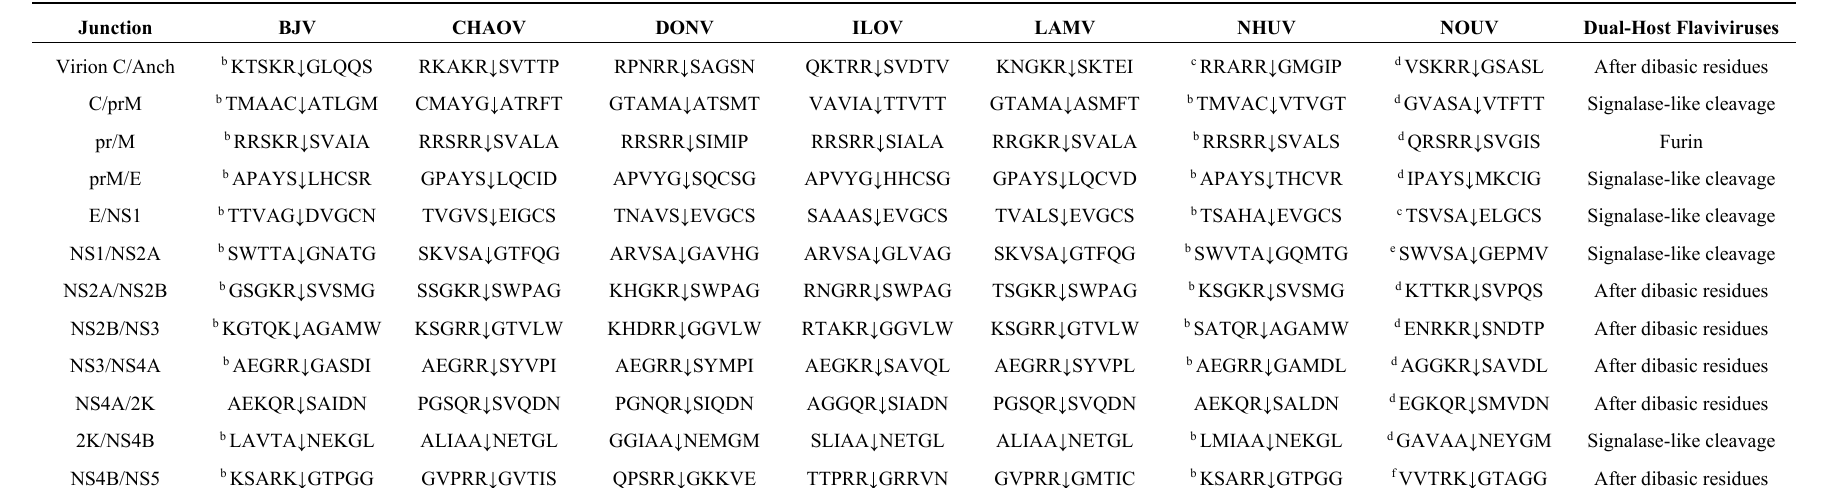
a Table 6. Predicted cleavage sites in the polyproteins of